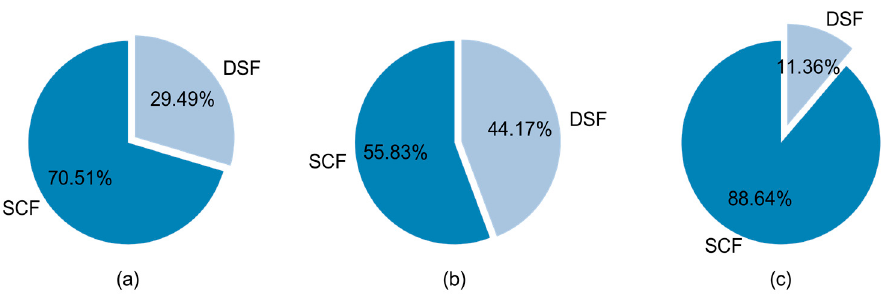
Figure 2. Distribution of failure modes in this dataset. ( a ) All RC slender beams; ( b ) RC slender beams without transverse reinforcements; ( c ) RC slender beams with transverse reinforcements.